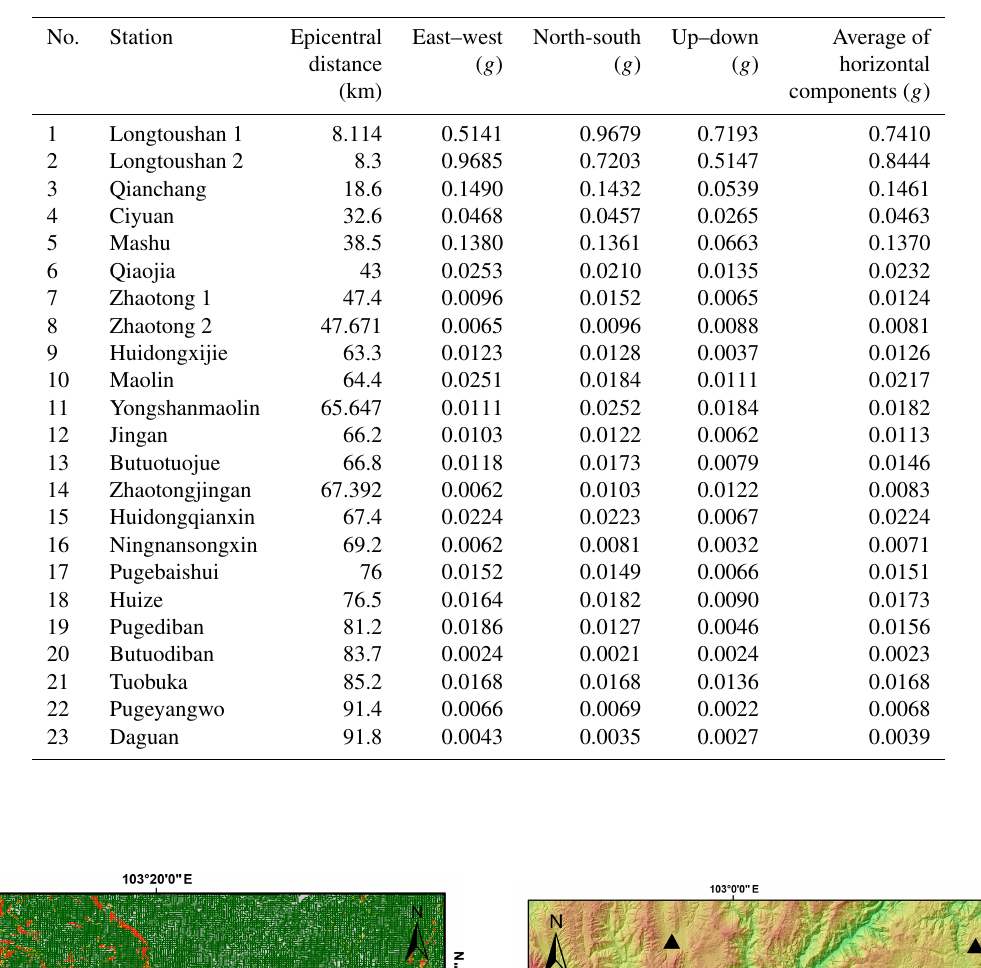
Table 2. Station records of three components of peak ground acceleration.